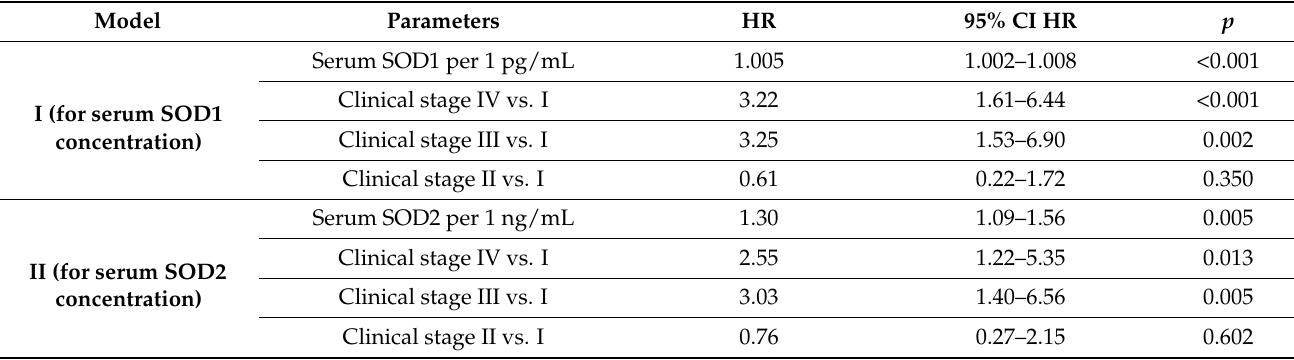
Table 4. Multiple Cox regression models predicting lung cancer mortality.